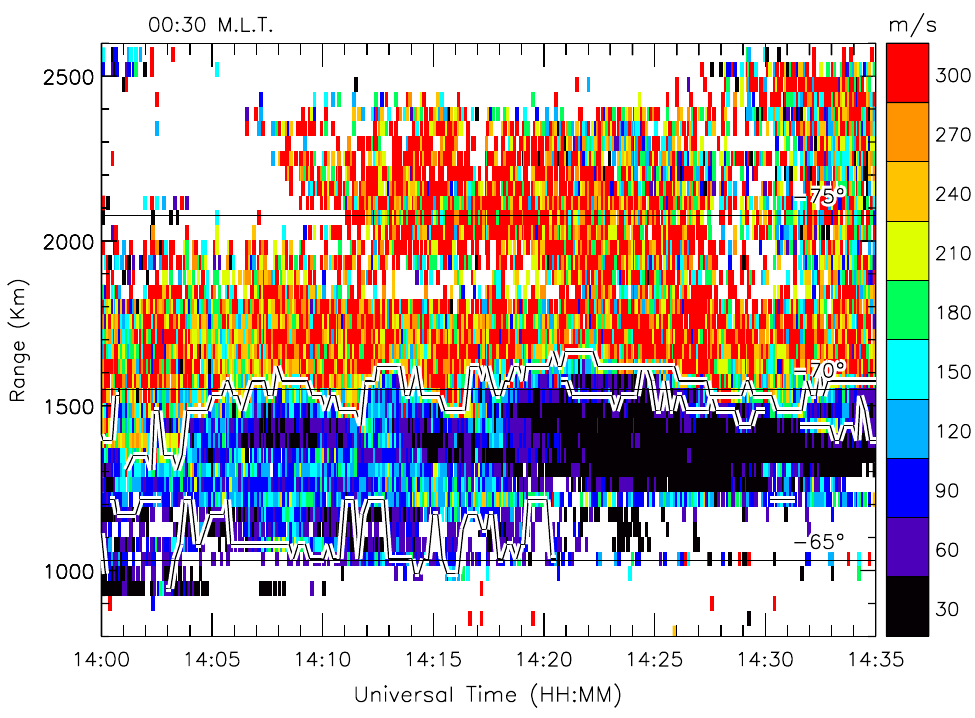
Fig. 6. Range-time plots of the radar spectral widths measured on TIGER beam 4 at 6-s time intervals during 14:00 to 14:35 UT on 1 April 2000. Black on white fluctuating curves delineate the SWBs identified using the C-F algorithm with thresholds of 50ms − 1 and 150ms − 1 . determined on all sixteen beams using a spectral